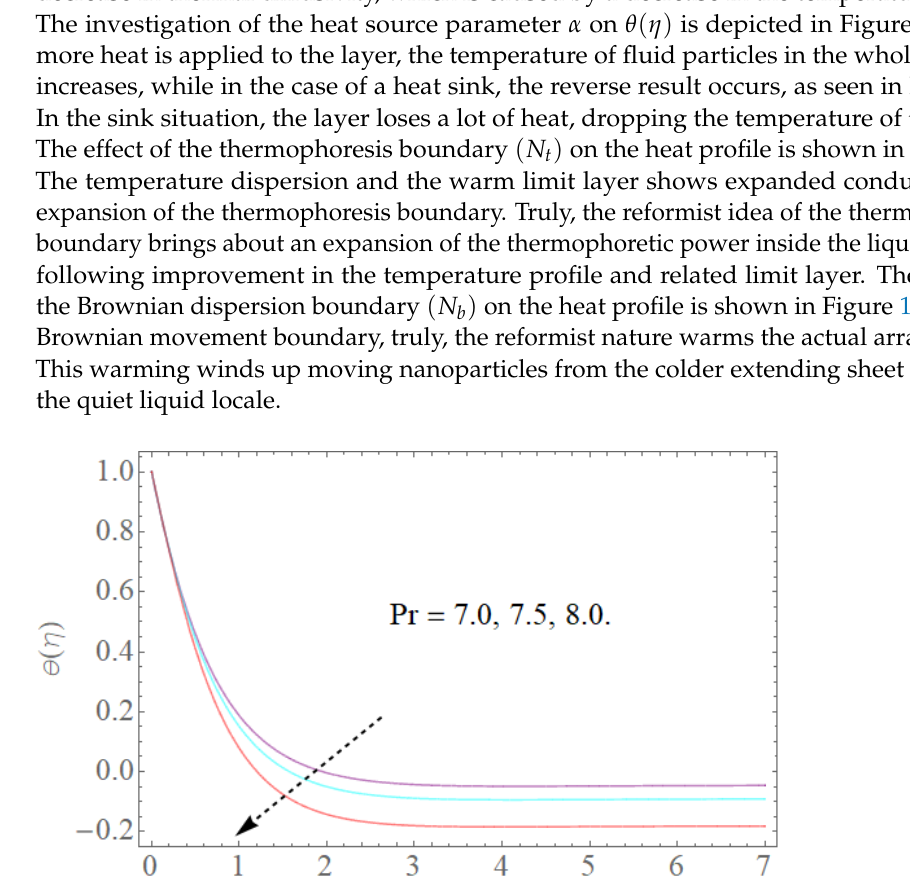
Figure 8. The effect of Pr on θ ( η ) when N b = 0.3, α = 1.0, N t =